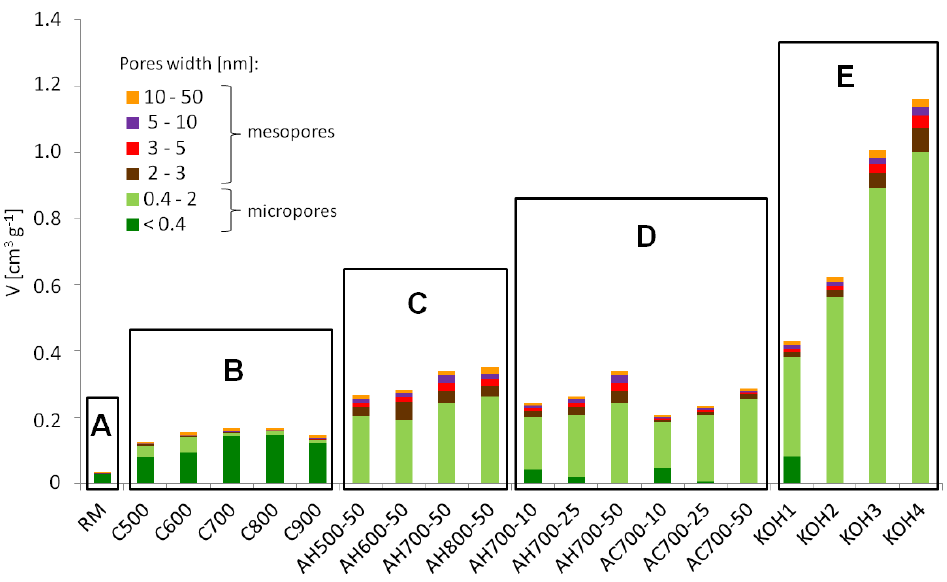
Figure 3: Distribution of micro- and mesopores volume according to pore size in raw material (A), chars (B) and activated carbons obtained by steam activation at different temperatures (C), steam and carbon dioxide activation to different burn-off (D) and chemical (KOH) activation (E).